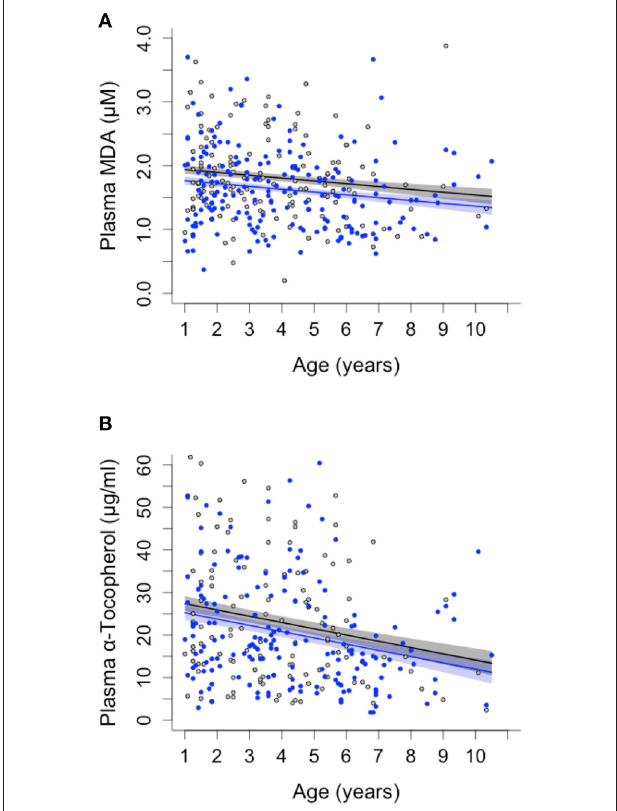
FIGURE 2 | Sex differences and age-related changes in plasma malondialdehyde (MDA) and plasma vitamin E ( α -tocopherol) concentration in banded mongooses. (A) MDA decreased with age of individuals and was consistently lower in male (blue) than in female (black) banded mongooses. (B) Vitamin E ( α -tocopherol) decreased with age in both sexes. Plots show LMM model predicted values ± SE controlling for random effects of individual and group, and the raw